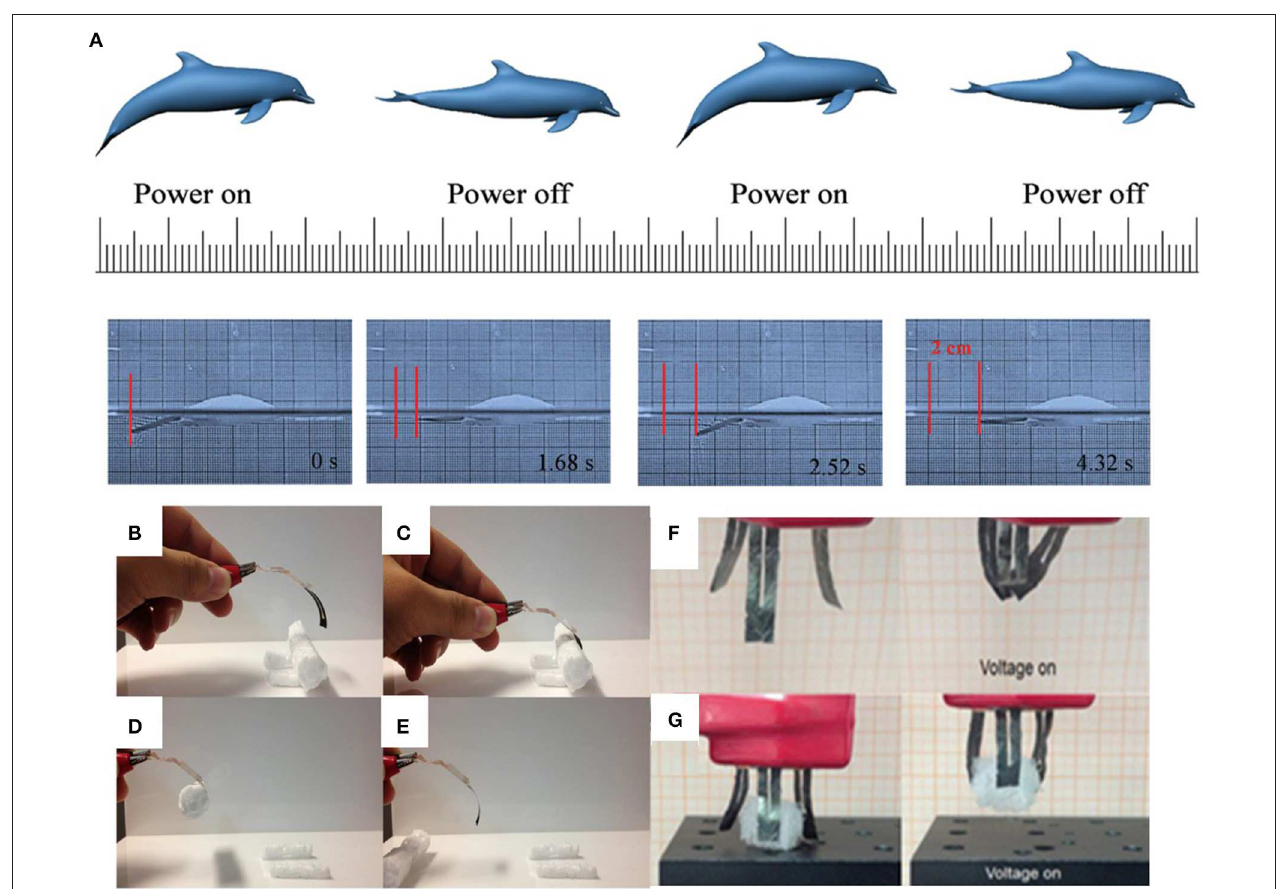
FIGURE 7 | (A) Diagram to demonstrate the fish-like robot swimming, when the power is on or off, the “tail” bends down or up, then the fish-like robot will swim forward. The dimensions of the fish tail (the graphene-PVDF bimorph robot and the fish body (Expandable PS) are 14 × 3mm 2 and 30 × 8mm 2 , respectively (reprinted with permission from Xiao et al., 2016. Copyright 2016 Wiley-VCH). (B) Laser reduced graphene oxide-based ETA without driving voltage. (C) The laser reduced graphene oxide-based electrothermal actuator is driven by the voltage of 65 V. (D) The LRGO-based ETA is hooking the plastic foam for moving a distance. (E) The driving voltage is switched off and the plastic foam is placed on the test bed (reprinted with permission from Zhang et al., 2017. Copyright 2017 Wiley-VCH). (F) A “tri-finger” mechanical gripper with 10V turned off (left part) and turned on (right part). (G) A larger object is grabbed by the “tri-finger” gripper at applied 10V (reproduced from Hu et al., 2014 with permission from The Royal Society of